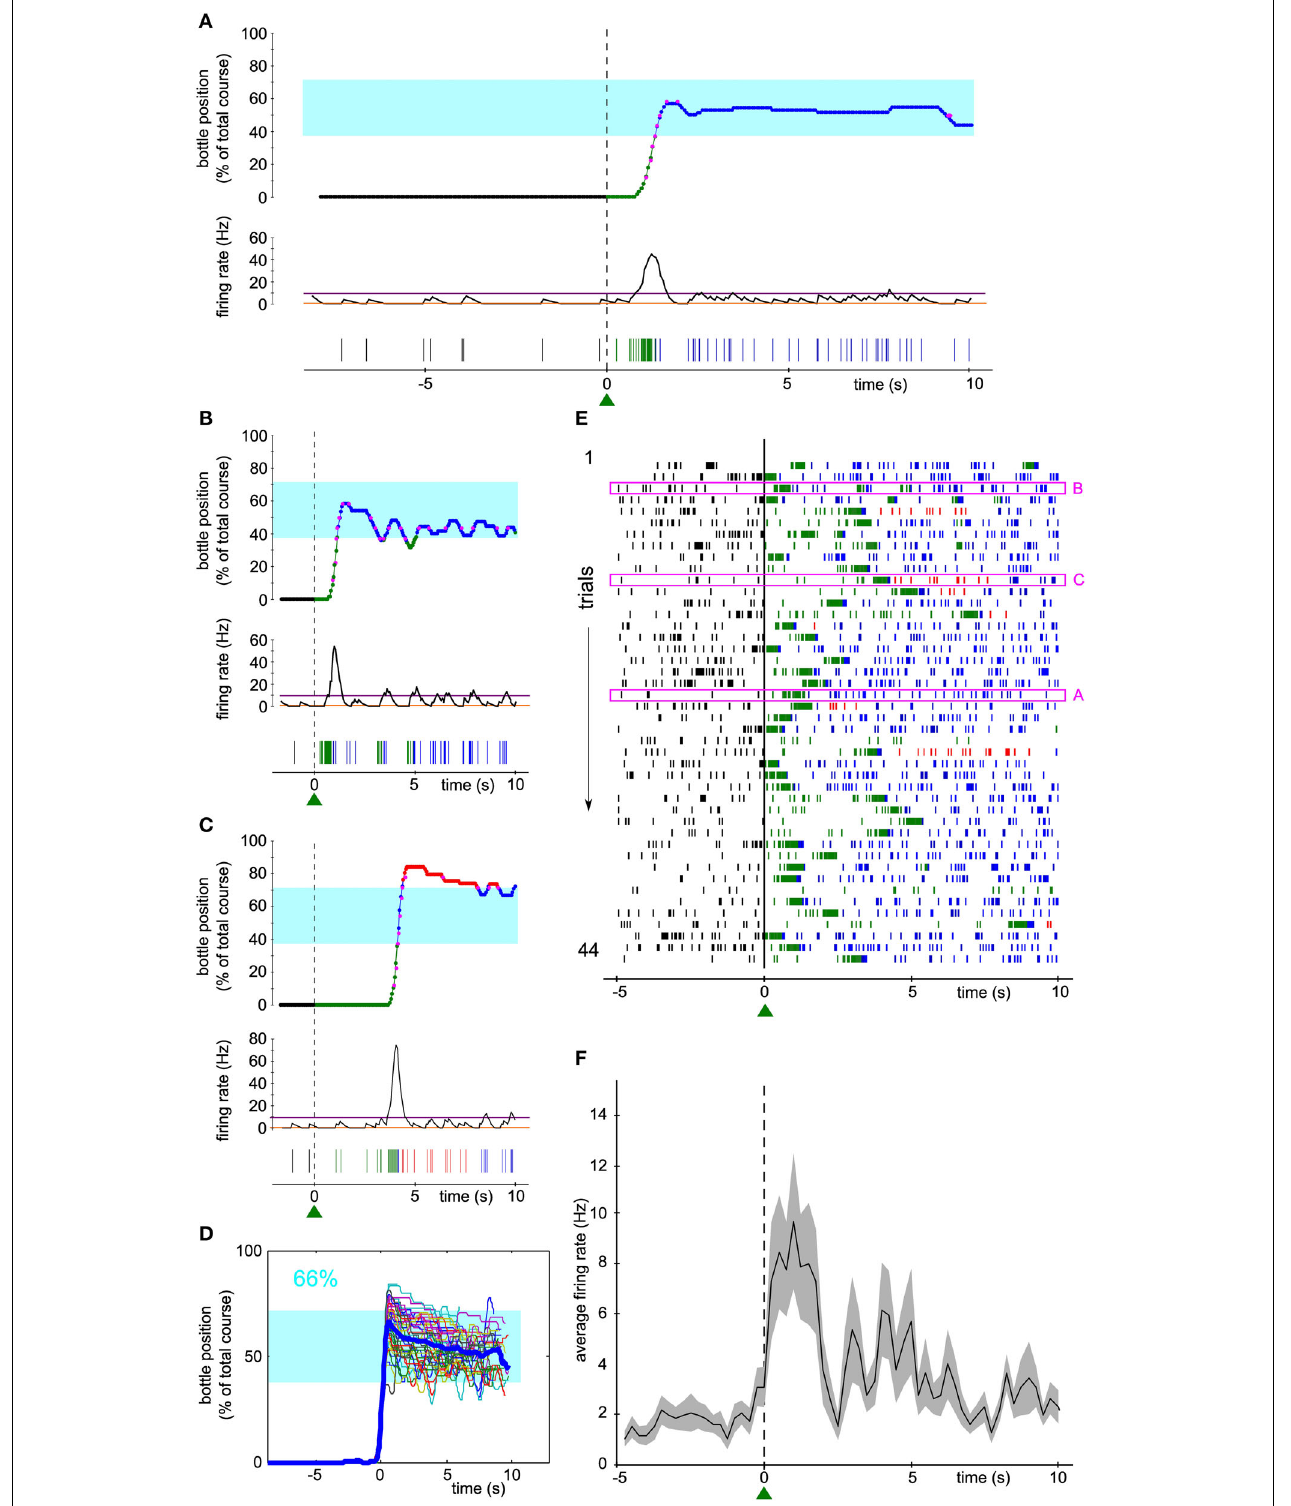
FIGURE 2 | Activity of a single unit controls the bottle position in real time to allow drinking. (A–C) Top, reconstruction of the bottle movement during three trials for one neuron during one session, color coded according to waiting/trial status and bottle position zones as in Figure 1 . Middle,